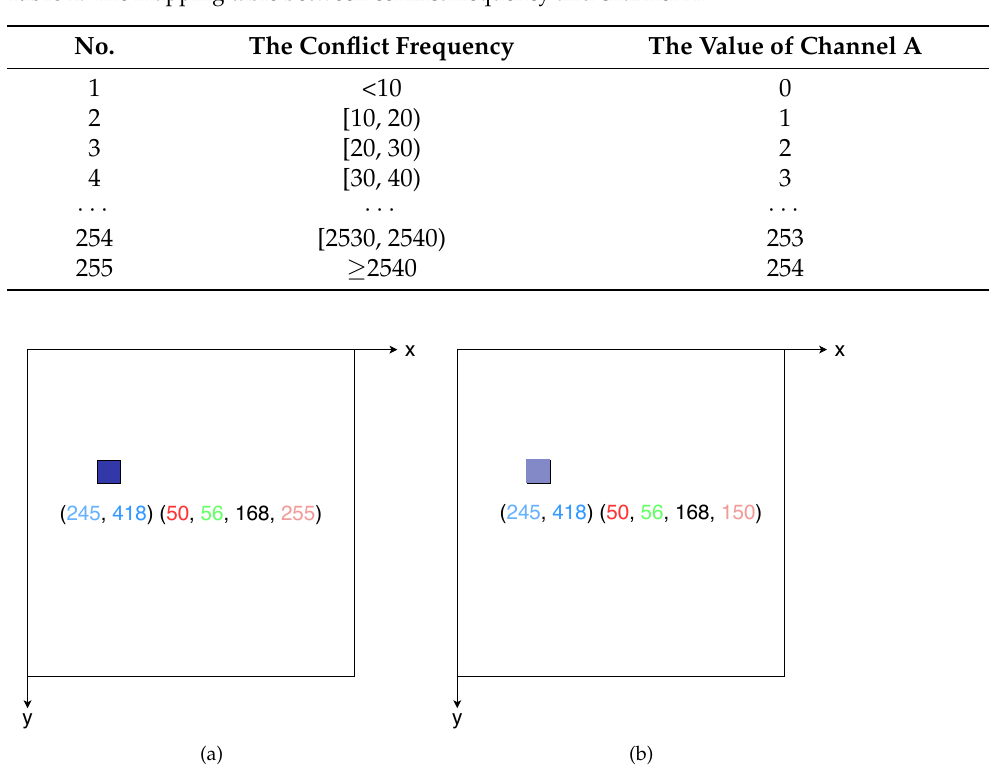
Figure 3. Pixel points after first mapping and 1500 mappings of the basic block. ( a ) Pixel point after the basic block’s 1st mapping; ( b ) Pixel point after the basic block’s 1500th